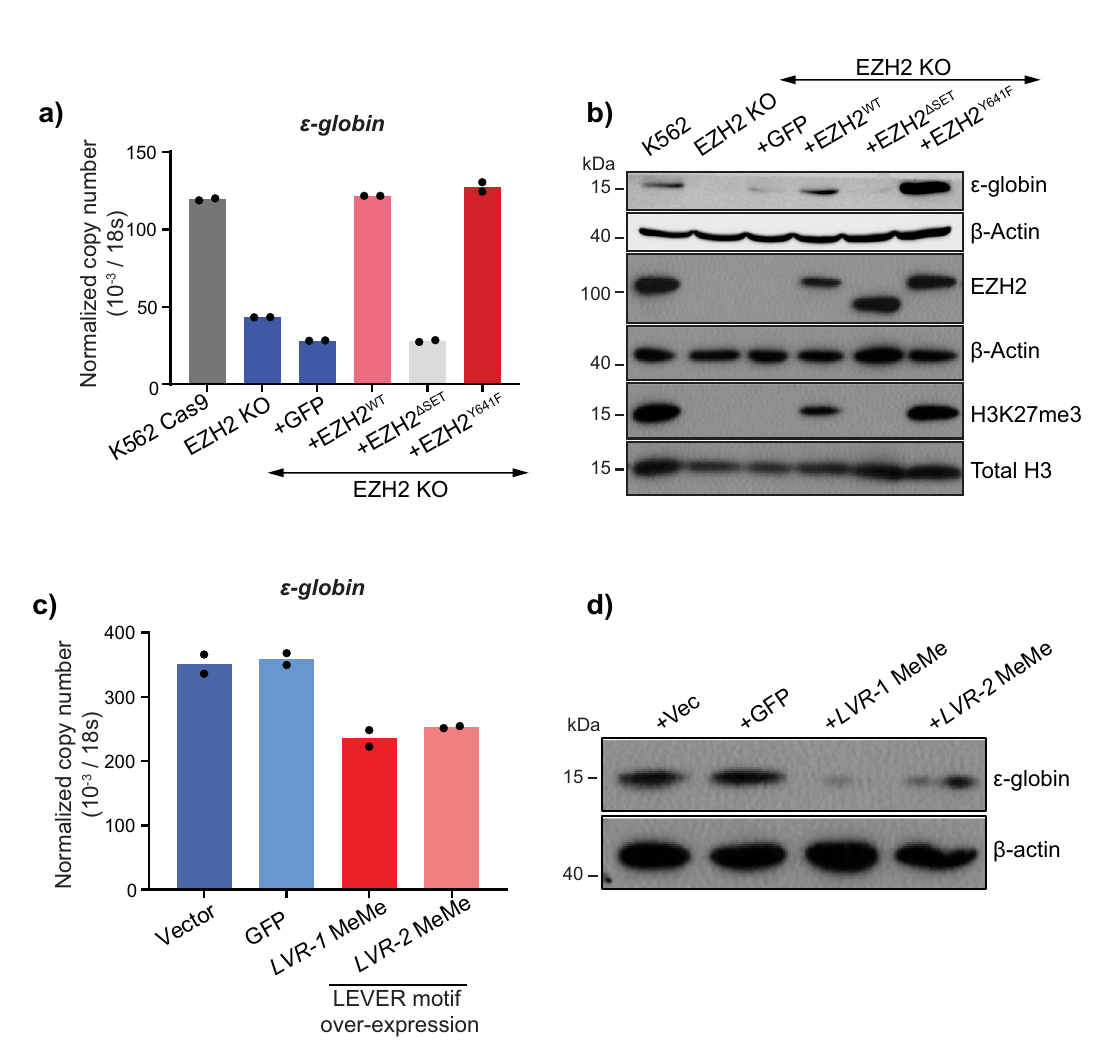
Fig. 3 PRC2 enzymatic function maintains ε -globin expression in K562. a RT-qPCR analysis of ε -globin in K562 Cas9-expressing parental cells, EZH2 knock-out (EZH2-KO) cells, and EZH2-KO cells rescued with GFP, EZH2, EZH2 Δ SET , and EZH2 Y641F . EZH2 Δ SET , truncated EZH2 without methyltransferase enzymatic domain; EZH2 Y641F , EZH2 gain of methyltransferase enzymatic function mutation. The EZH2-KO cells were transduced with lentivirus to stably express these constructs. Data from technical replicates of one biological sample is shown. b Western blot analysis of ε -globin, EZH2, and global H3K27me3 in K562 wild type, EZH2 KO, and rescue cells as in a . β -actin and total histone H3 were used as loading controls. c , d ε -globin expression in LEVER KO K562 cells rescued by LVR-1 MeMe or LVR-2 MeMe. LVR-1 and LVR-2 MeMe represent RNA fragments encompassing MeMe enriched EZH2- interacting RNA motif (Supplementary Fig. 2b) within the LVR-1 and LVR-2 regions (Supplementary Fig. 5a). LEVER KO K562 cells were transduced with empty vector, GFP RNA, LVR-1 MeMe, or LVR-2 MeMe expressing lentivirus and analyzed for ε -globin expression using c RT-qPCR and d western blot. For ( c ), Data from technical replicates of one biological sample is